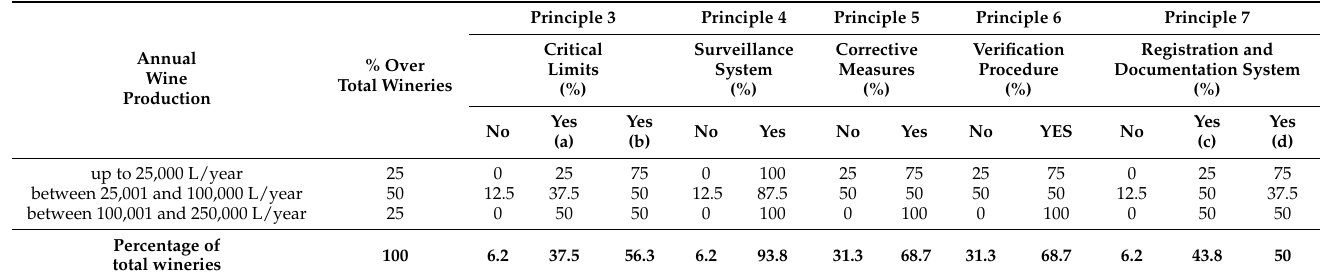
Table 5. Practical implementation of principles by type of winery, according to their annual wine production and by the total of the